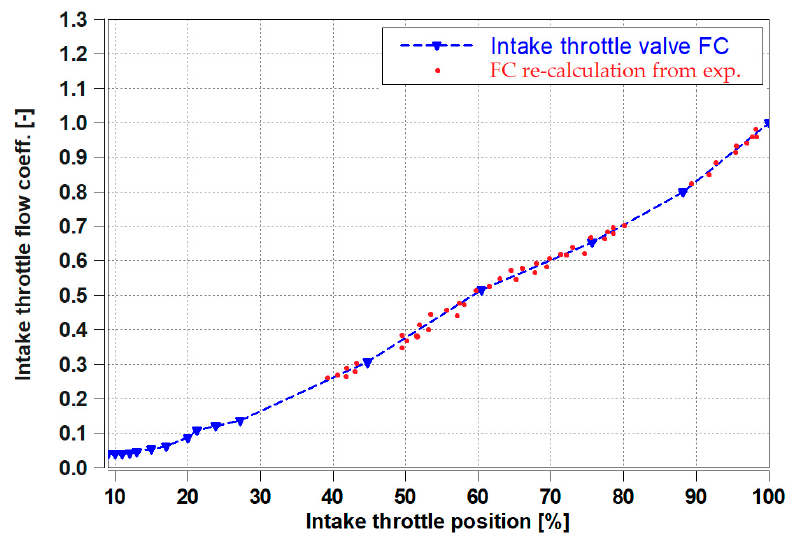
Figure 5. Parametrization of the flow coefficient of the intake throttle valve. A plenum, instead, is a volume component that contains gas. During the engine sim- ulation process, it is filled up and emptied with fresh air or exhaust gases thanks to mass balance equation, energy and species concentration, and state equation calculation. The